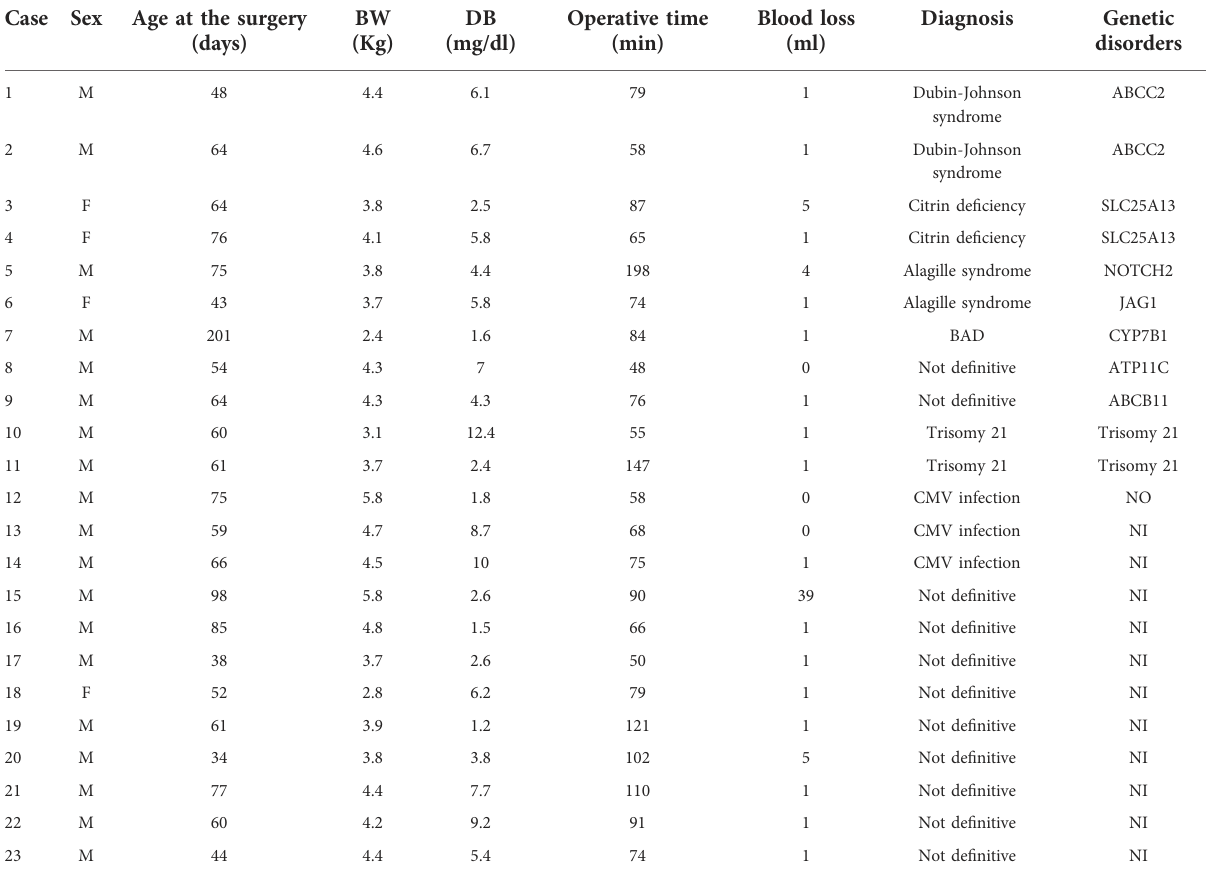
TABLE 2 The 23 patients for whom BA was ruled out